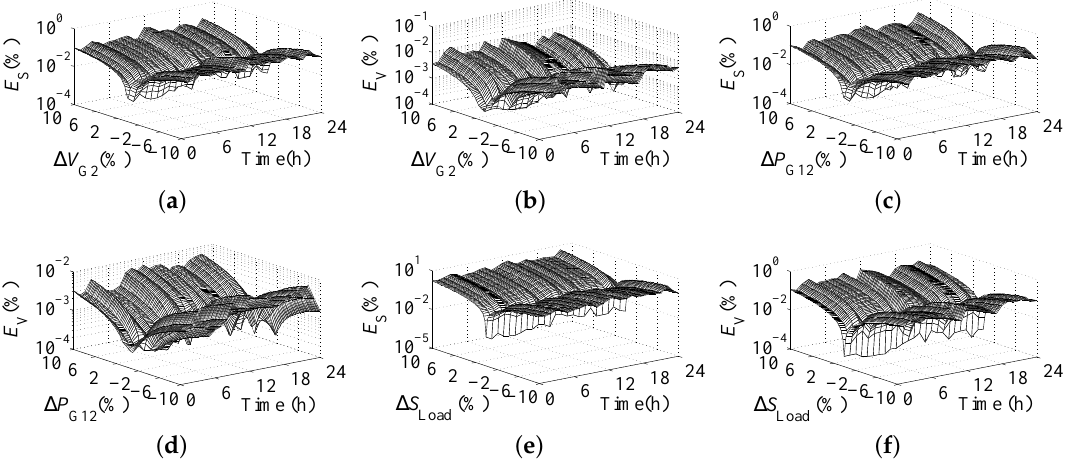
Figure 9. Relative errors of the Ward equivalent model as obtained using the ERL algorithm in the different scenarios. ( a ) E S in Scenario 1; ( b ) E V in Scenario 1; ( c ) E S in Scenario 2; ( d ) E V in Scenario 2; ( e ) E S in Scenario 3; ( f ) E V in Scenario